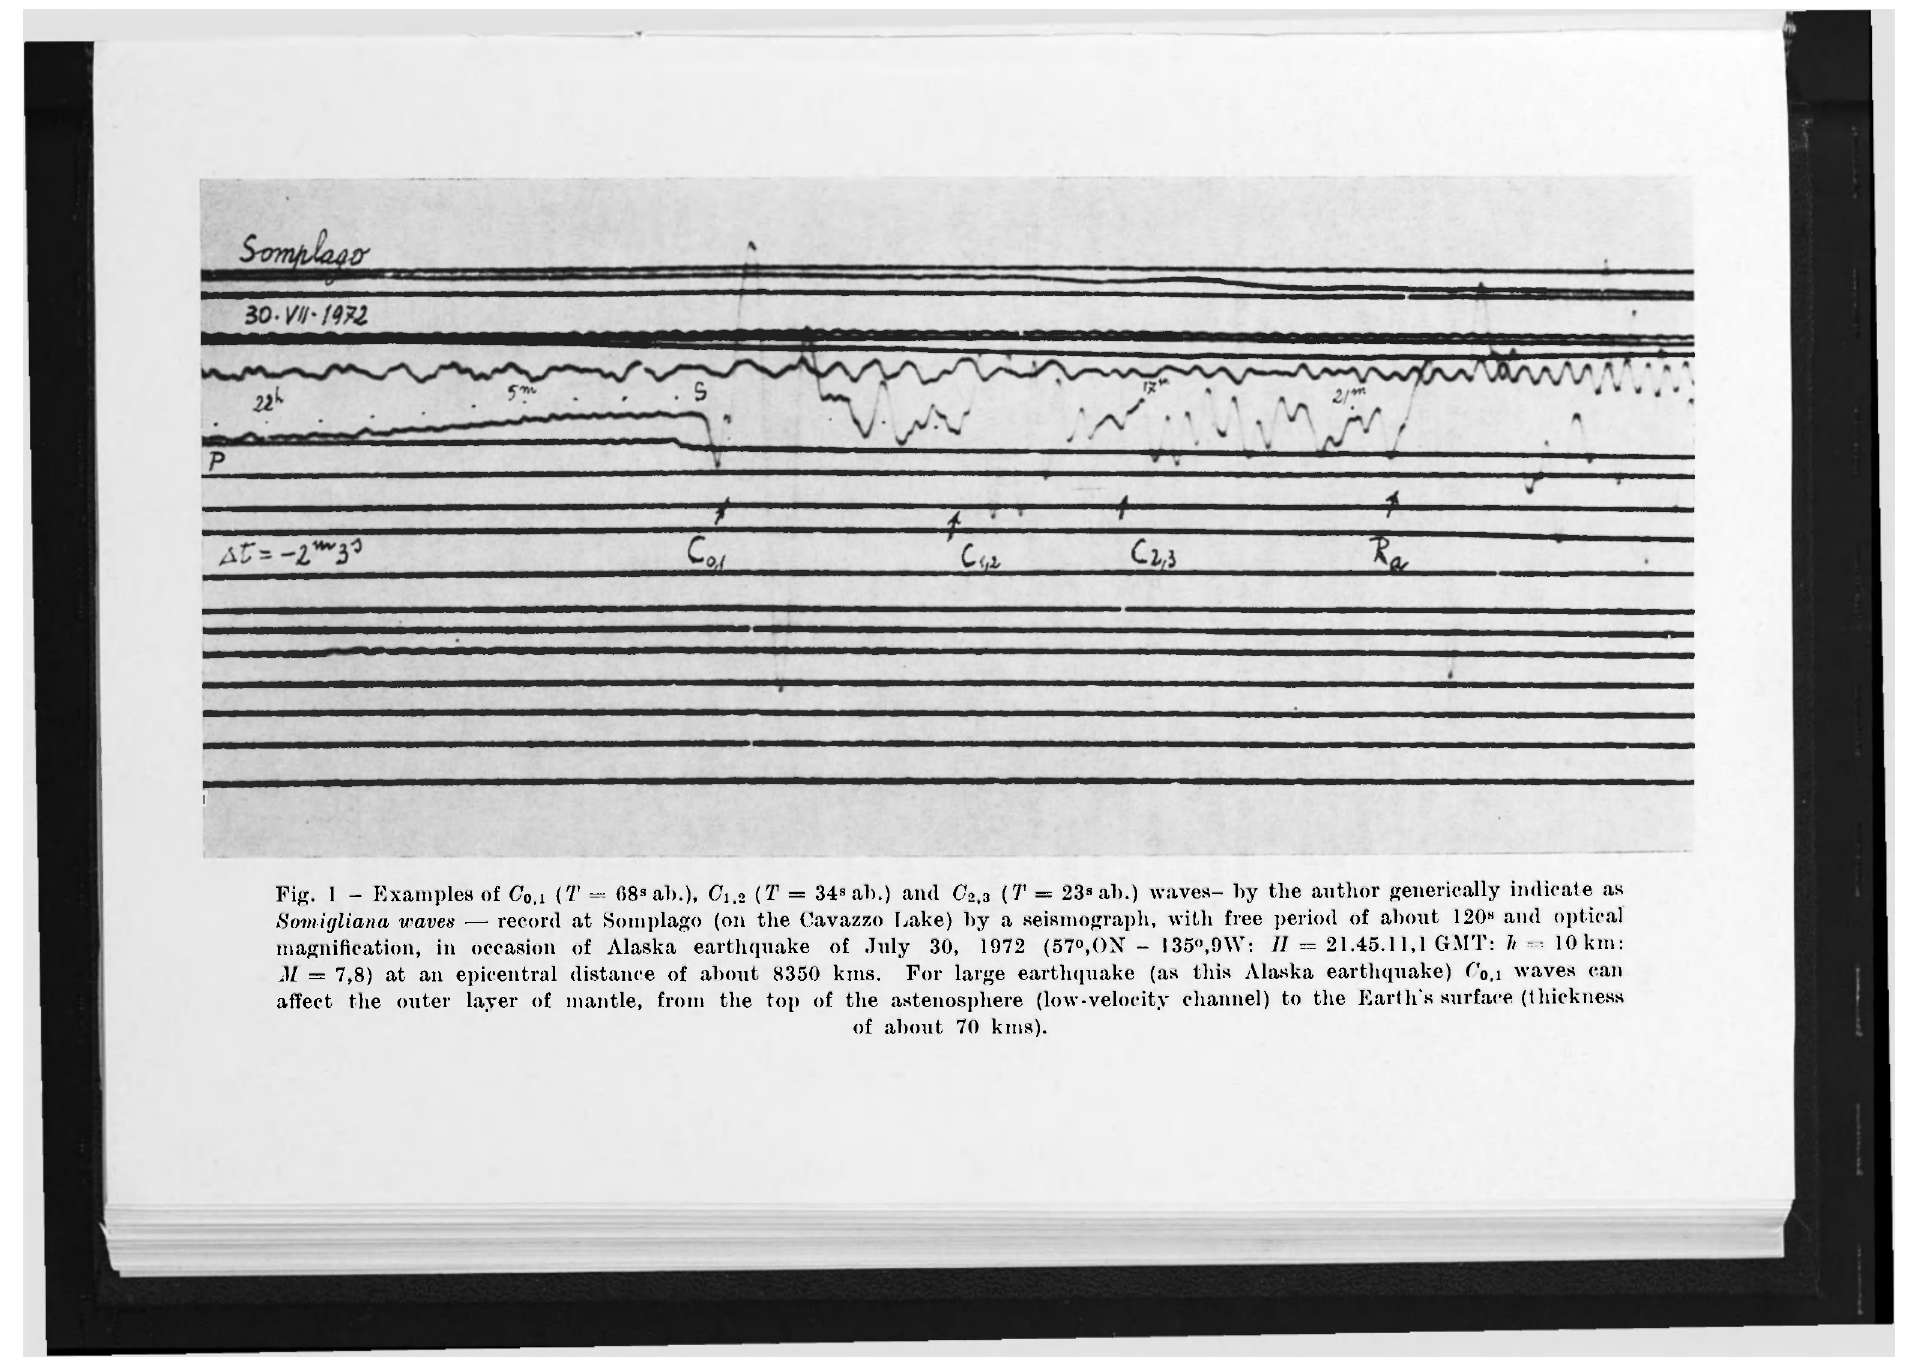
Fig. 1 - Examples of C 0 ,i (T = 68 s ab.), Ci, 2 (T = 34 s ab.) and C 2 , 3 (7 1 = 23 s ab.) waves- by the author generically indicate as Somigliana waves — record at Somplago (011 the Cavazzo Lake) by a seismograph, with free period of about 120 s and optical magnification, in occasion of Alaska earthquake of July 30, 1972 (57°,ON - 135",9\V: H = 21.45.11,1 GMT: li = 10 km: M = 7,8) at an epicentral distance of about 8350 kins. For large earthquake (as this Alaska earthquake) C 0 .i waves can affect the outer layer of mantle, from the top of the astenosphere (low-velocity channel) to the Earth's surface (thickness of about 70